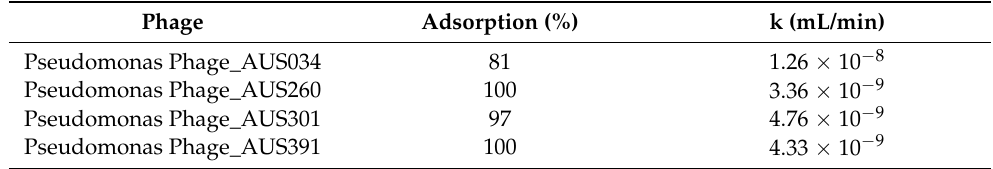
Table 7. The adsorption percentages and adsorption constants of the phage isolates.